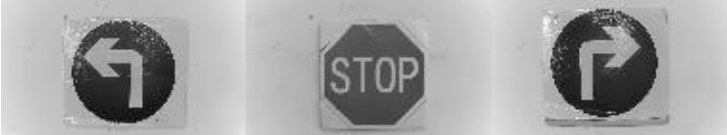
Figure 4. Positive sample picture.